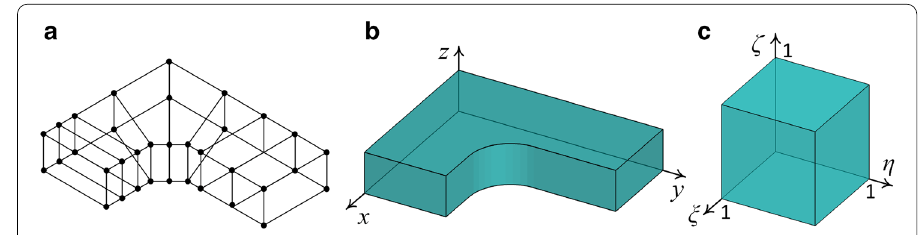
Fig. 27 The control net for generating a NURBS volume ( a ), NURBS-based description of the physical domain ( b ) and computational domain ( c )